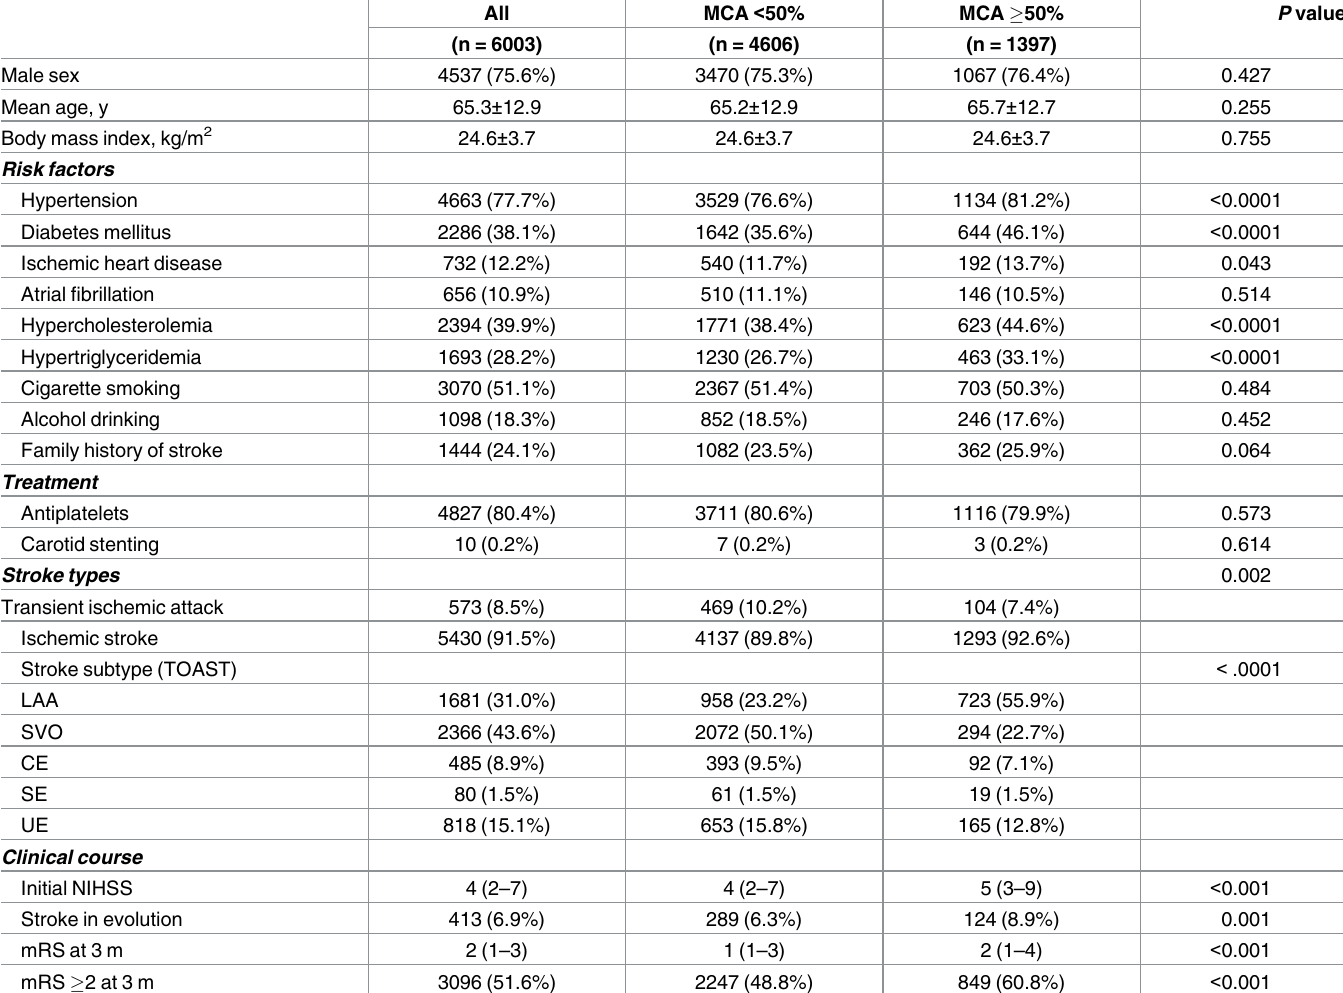
Table 1. Comparison between patients with or without MCA